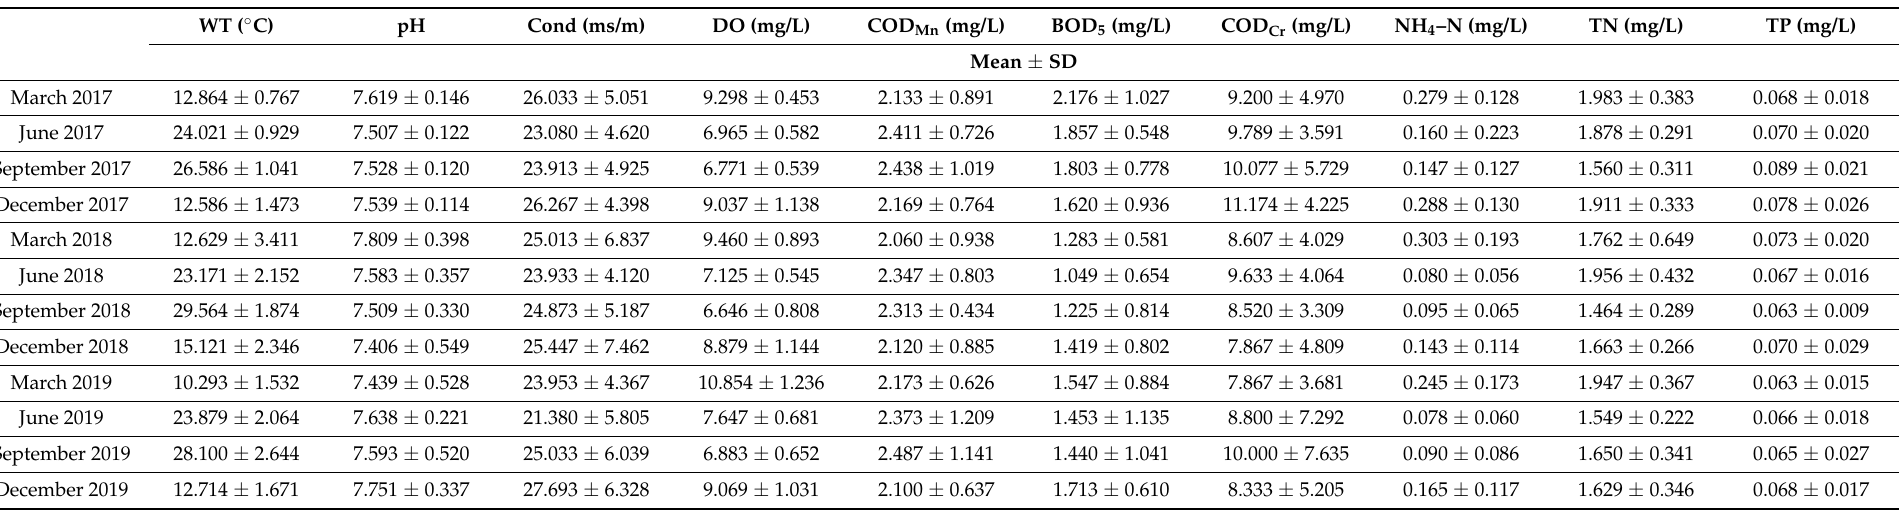
Table 1. Variation characteristics of significant water quality factors of Dongting Lake from 2017 to